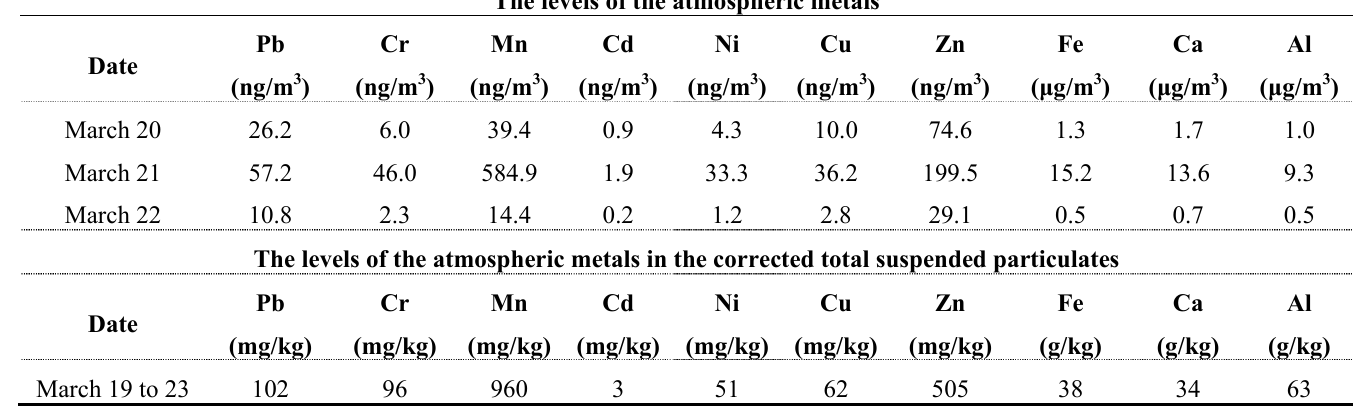
Table 1. Levels of 10 atmospheric heavy metals (Pb, Cr, Mn, Cd, Ni, Cu, Zn, Fe, Ca, and Al) during the 3 days starting before and ending after the Asian dust day on March